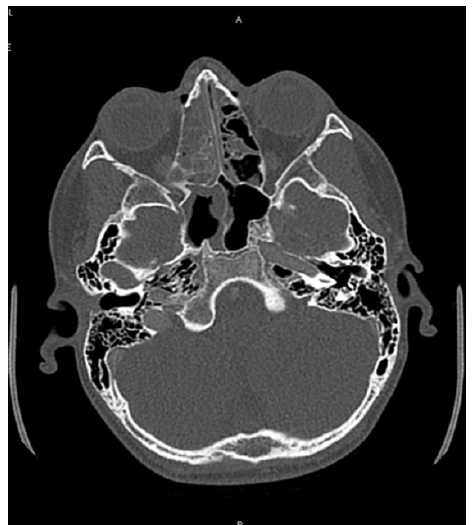
Image 1. Computed tomography of our patient showing right ethmoid (white arrow) and maxillary (white arrowhead) sinusitis with enhancement demonstrating abscess formation